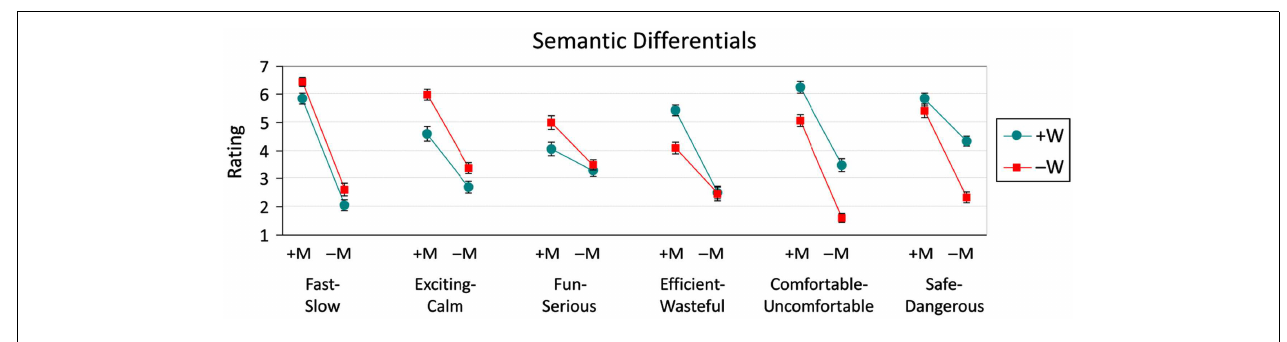
Fast-Slow, Exciting-Calm, and Fun-Serious. Prevention-oriented differentials include Efficient-Wasteful, Comfortable-Uncomfortable, and Safe-Dangerous. Each rating scale is 1 to 7, with 7 representing the first word of each